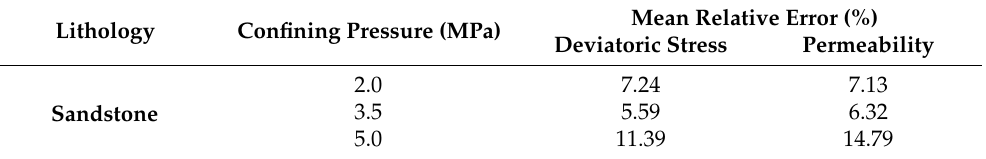
Table 4. Error of theoretical WCR deviatoric stress and permeability versus laboratorial